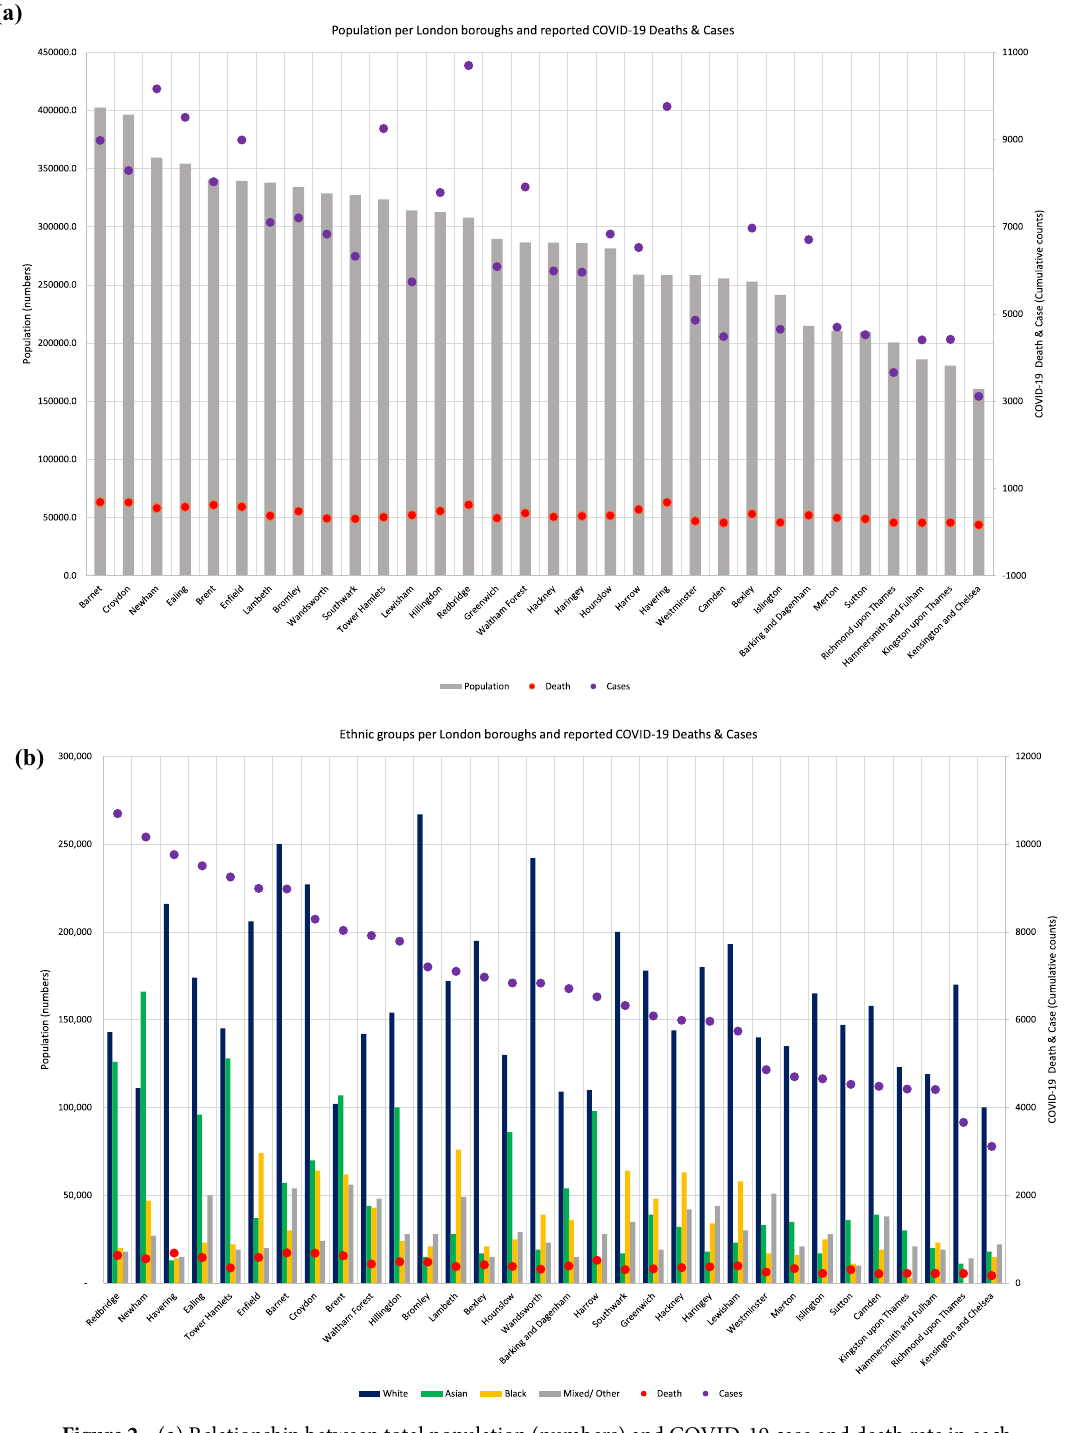
Figure 2. ( a ) Relationship between total population (numbers) and COVID-19 case and death rate in each London borough. ( b ) Relationship between total population (numbers) and ethnicity (numbers) and COVID-19 case and death rate in each London